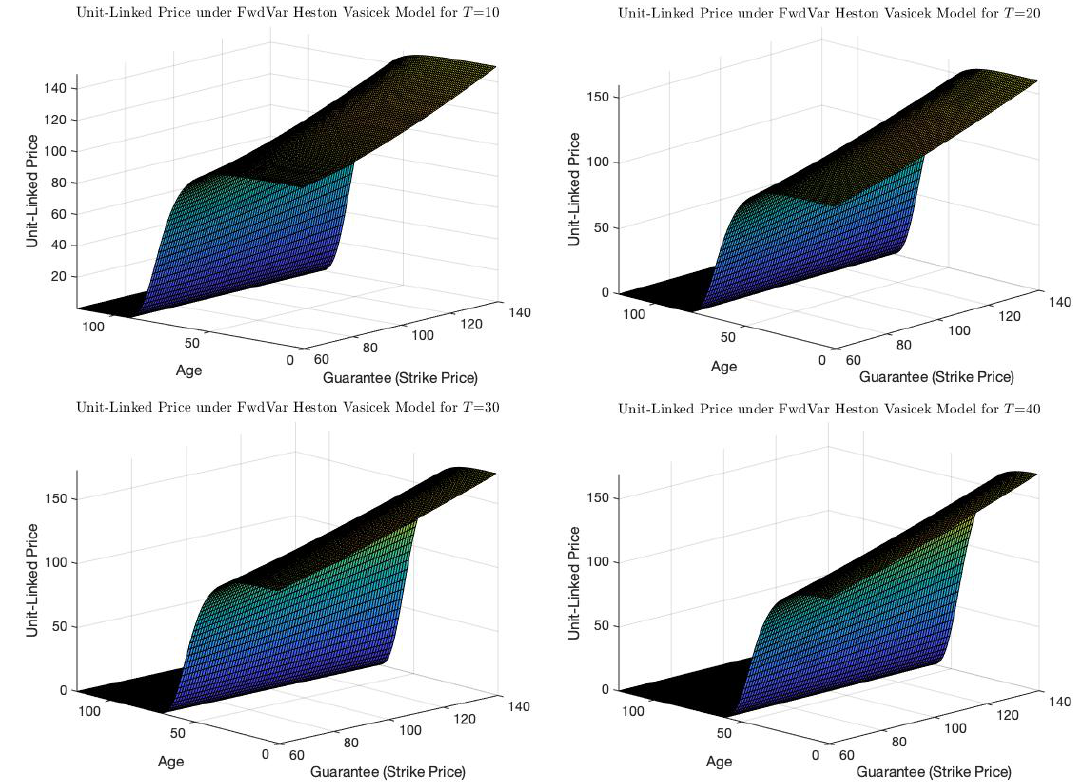
Figure 3. Unit-linked price surfaces under a Vasicek-Heston model written in forward variance for different policy maturities, in terms of the guaranteed amount desired by the insured and his age at the time of